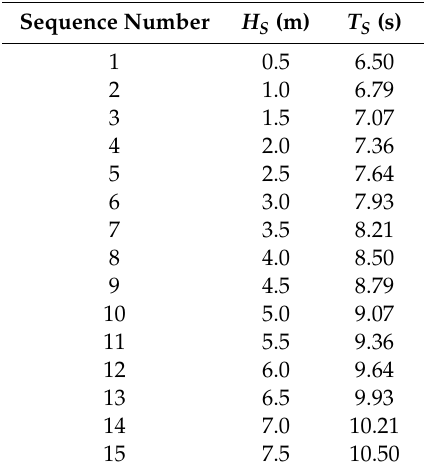
Table 1. Parameter settings for the test image